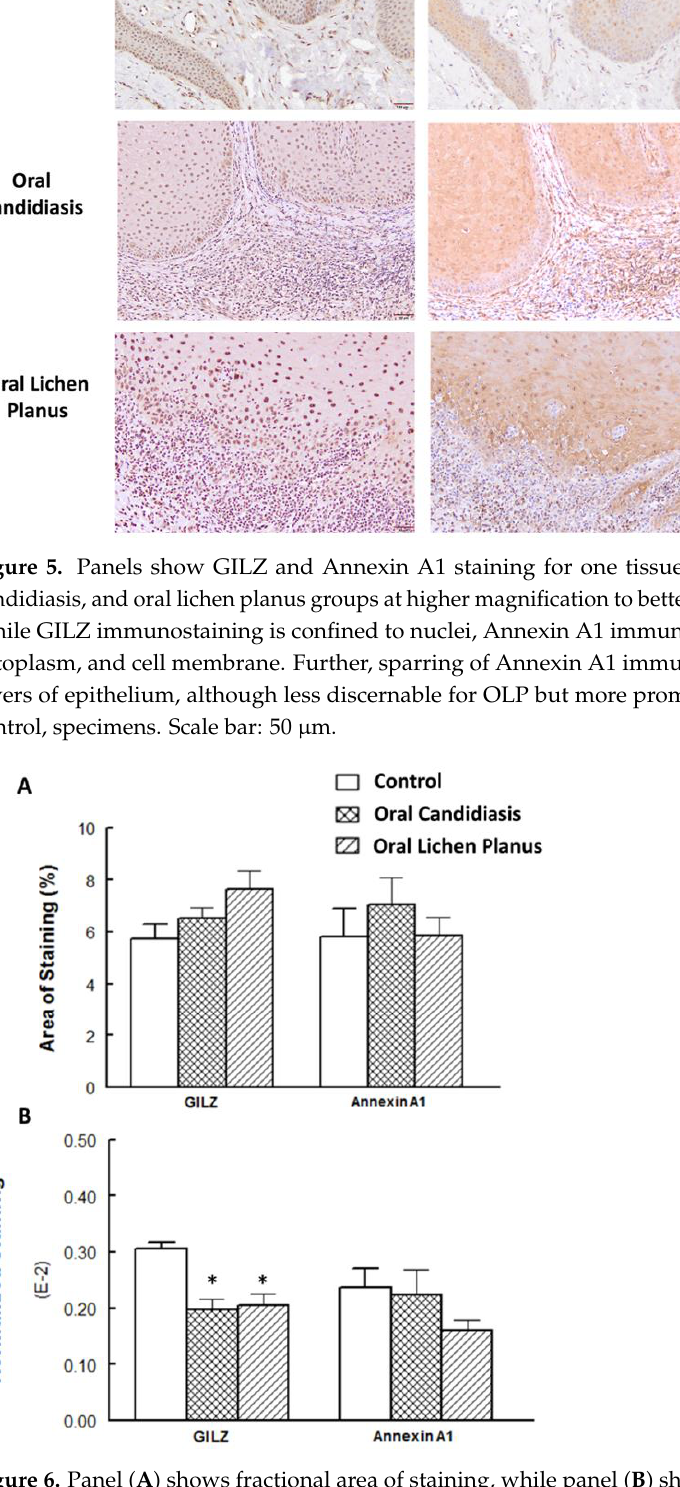
Figure 6. Panel ( A ) shows fractional area of staining, while panel ( B ) shows staining normalized to nuclei for proteins of interest. Data are means ± SEM for each condition; n = 5 – 10 specimens for each condition as indicated under Methods. * p < 0.05 compared to the control